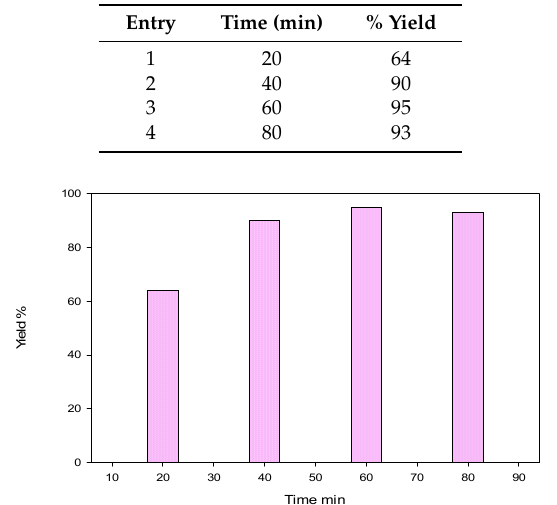
Figure 3. Milling of 2.5 g of o -phenylenediamine and 3 g of benzoic acid with 56.6 g of balls at 20 Hz.